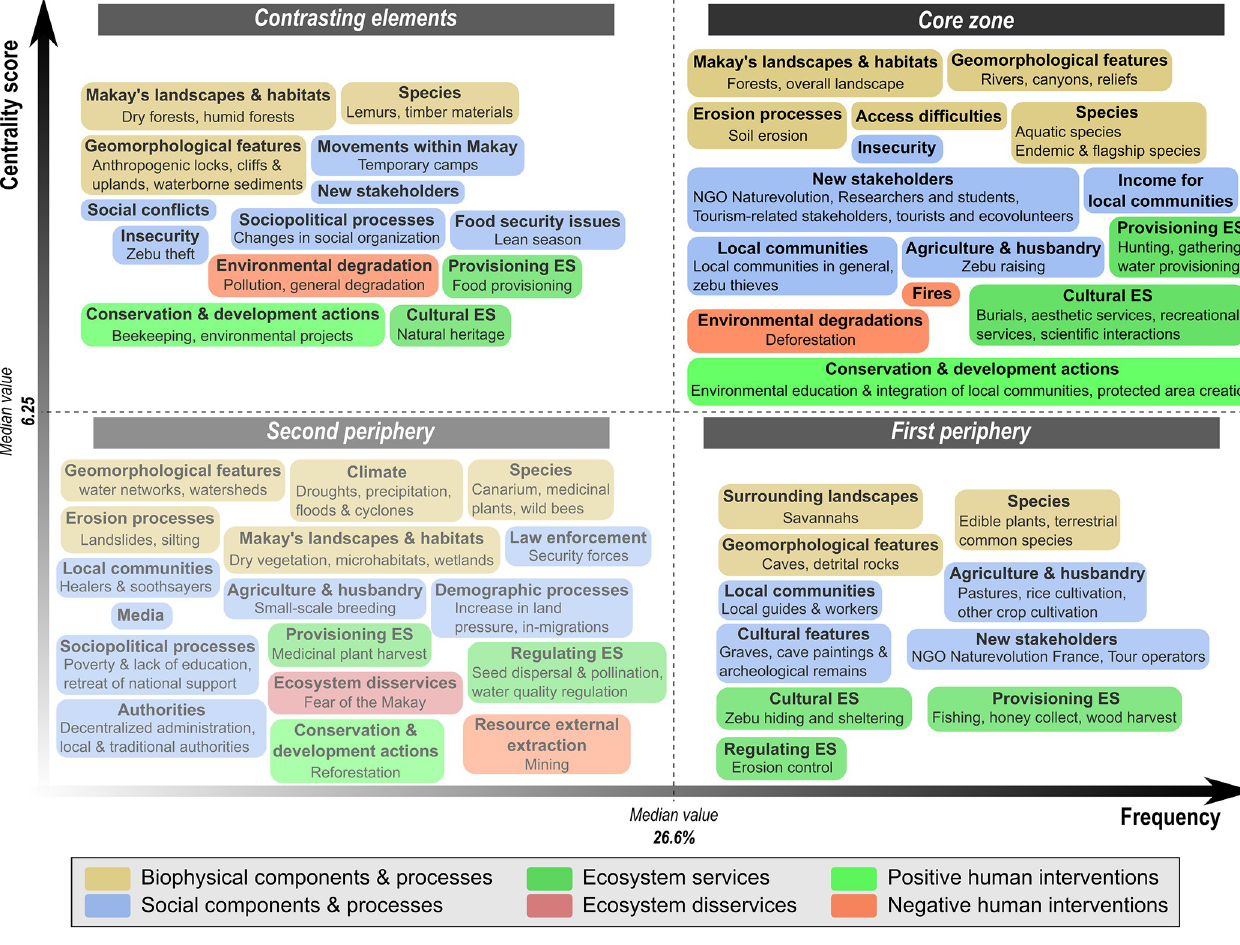
Fig 3. Content and structure of the Makay social representation held by the respondents. The four zones of the representation were named following [47], and the classification of elements was done based on centrality-frequency criteria (see S1 Appendix). Boxes correspond to component types, which regroup the components cited by respondents, and the color indicates the category. Only components cited by > 10% of the respondents are represented. See S2 Table in S1 Appendix for detail.